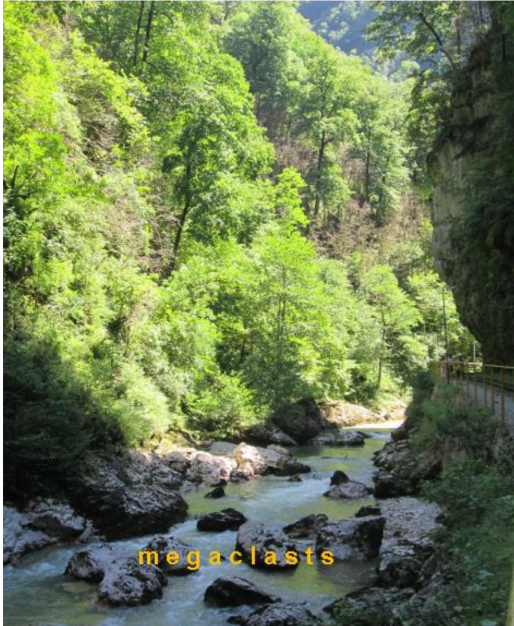
Figure 1. Typical megaclasts with the size of 1–3 m in the Guama Gorge (Krasnodar Region, Russia).